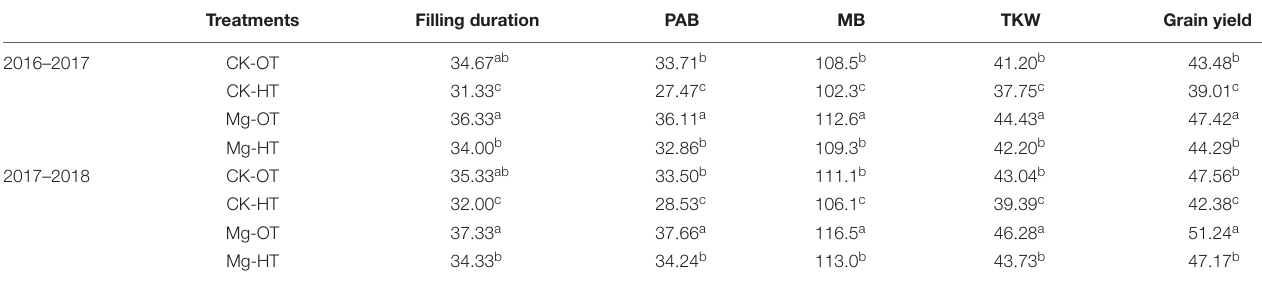
TABLE 1 | Effect of Mg application on the grain filling duration (days), post-anthesis biomass (PAB, g pot − 1 ), biomass at maturity (MB), 1000-kernel weight (TKW, g), and grain yield (g pot − 1 ) of wheat under high-temperature stress (HTS) during grain filling. Treatments Filling duration